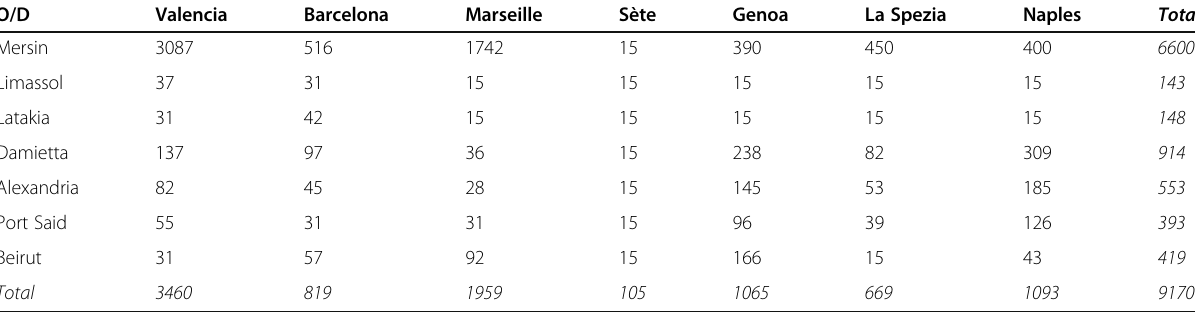
Table 3 Weekly O/D demand (lm) – From MENA to EU (year of reference: 2012) O/D